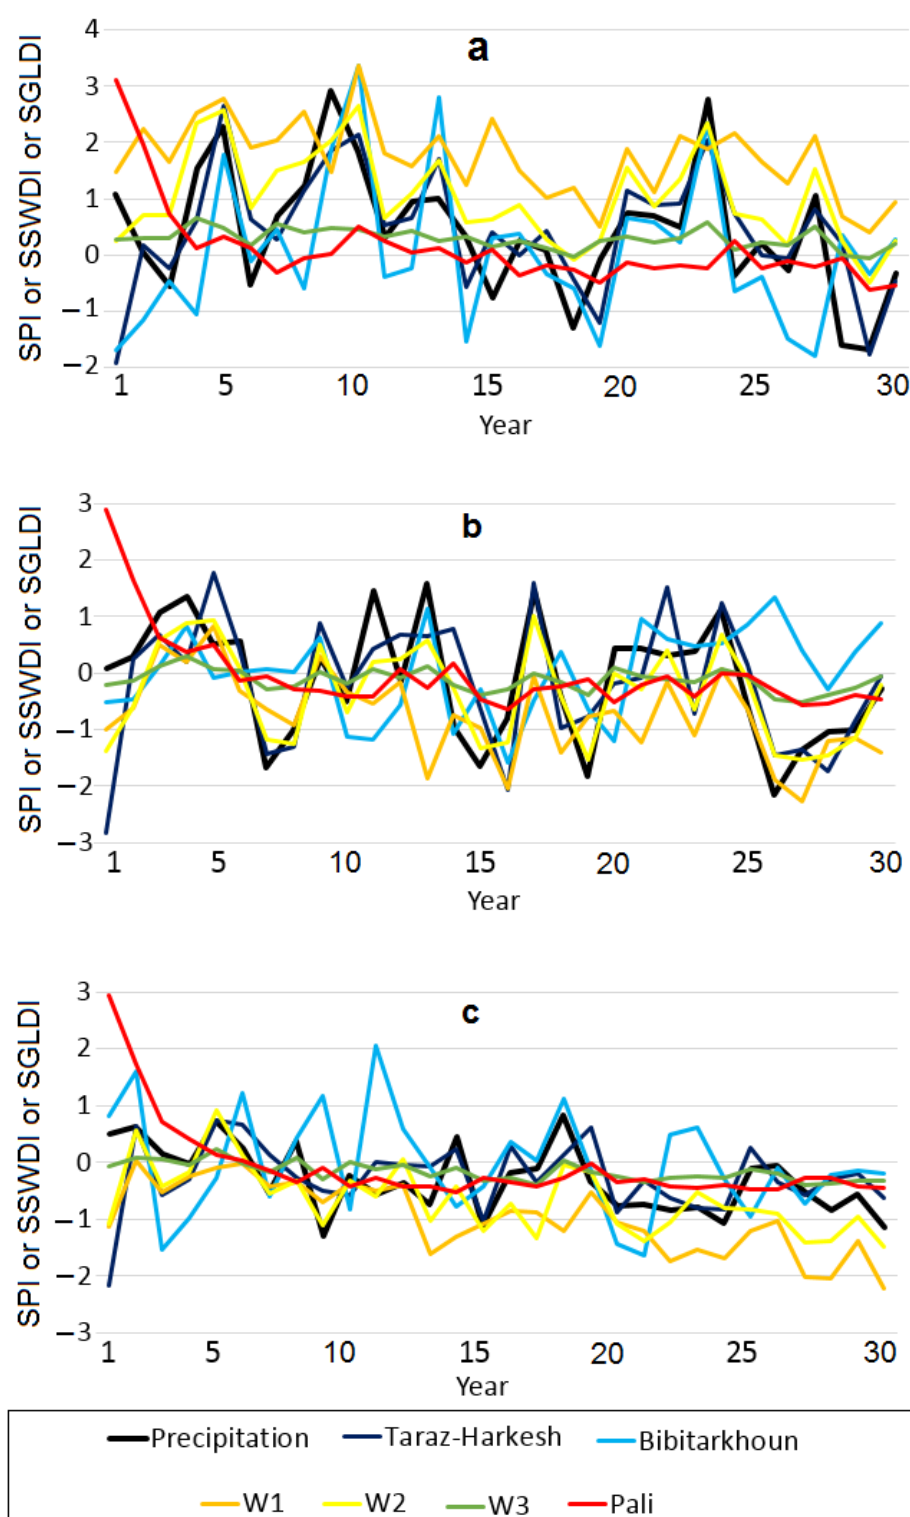
Figure 7. The SPI, the SSWDI and the SGLDI of various water resources in the Lali region in the base time period ( a ), the future time period under RCP4.5 ( b ) and the future time period under RCP8.5 ( c ) (years 1–30 indicate 1961–1991, as to the base time period and 2021–2050, as to the future time